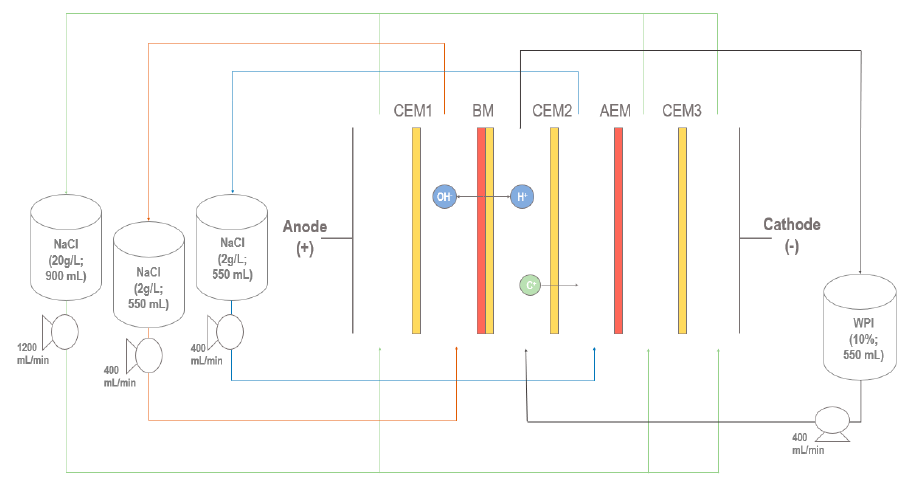
Figure 4. EDBM cell configuration for the electrochemical acidification of whey protein solution.